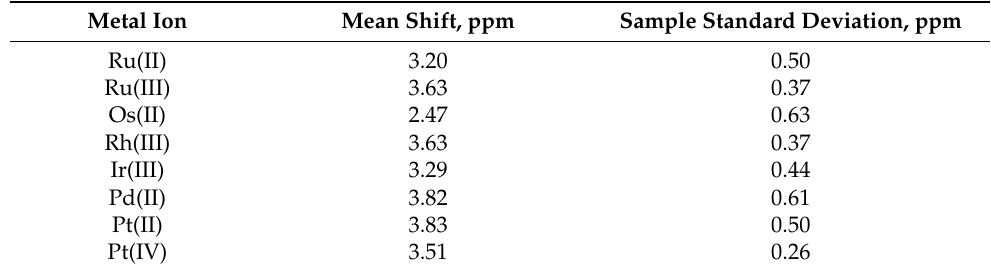
Table 8. The mean 1 H chemical shifts reported for α -hydrogen nuclei and the standard deviation of these shifts as a function of the metal